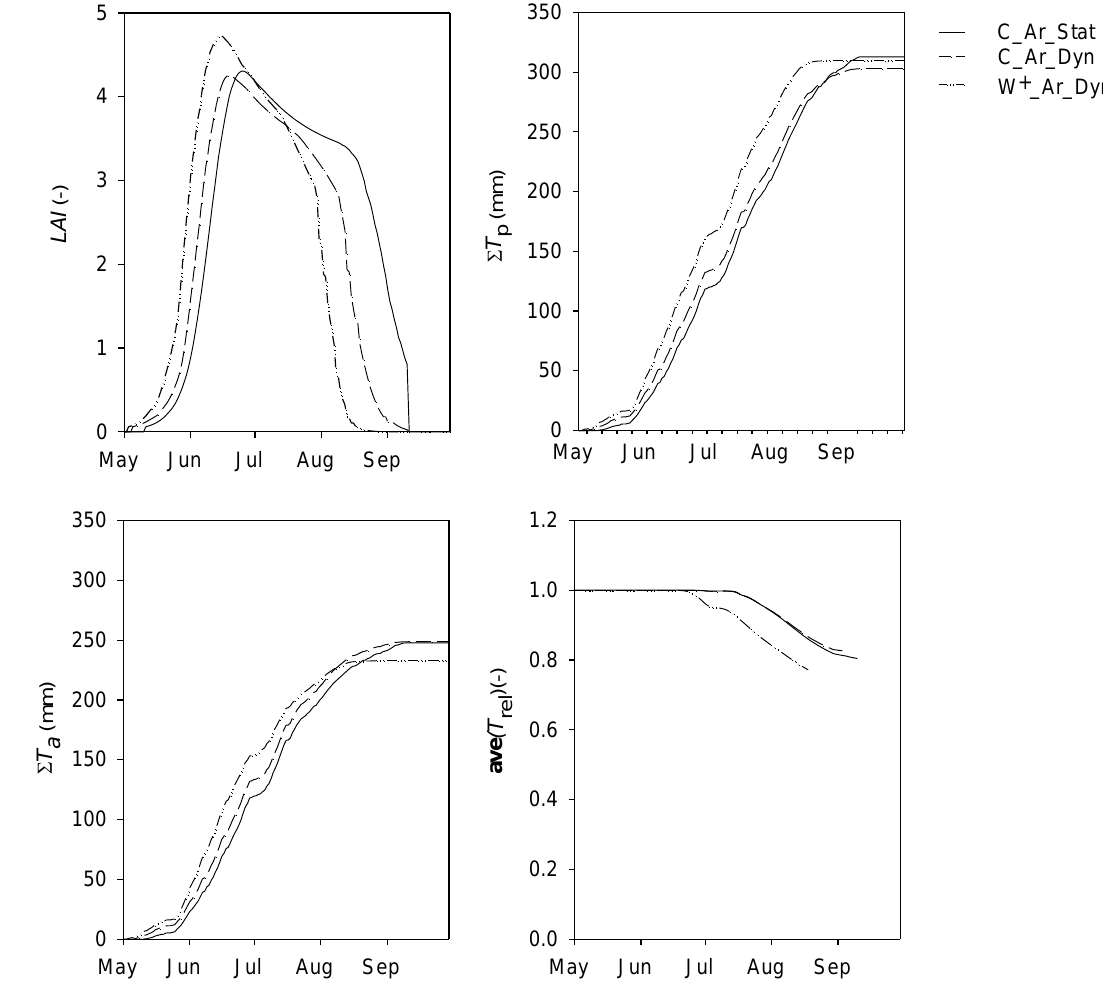
Fig. 10. Simulation results for arable land (potato) at evaluation point EP1 (Fig. 5) for three of the variants (Table 2): Current/W + -scenarios; Stat/Dyn – static/dynamic vegetation model. The simulations are for the year 2003 (warm year, current climate) and 2063 (W + -scenario).